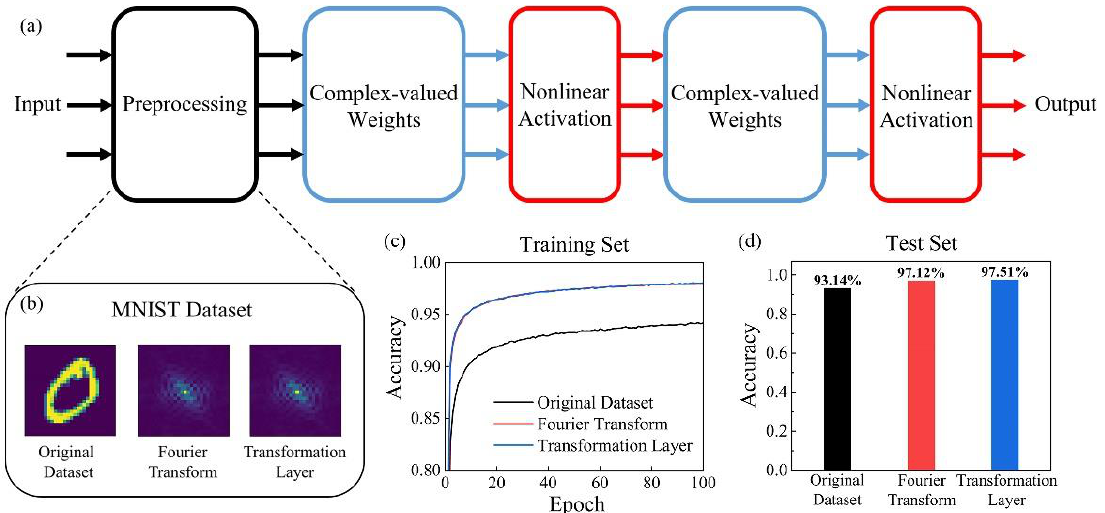
Figure 4. ( a ) A two-layer PCNN with preprocessing. ( b ) Different preprocessing of the MNIST dataset. Classification accuracies of the PCNN on the MNIST ( c ) training set and ( d ) the test set with different preprocessing, which are original dataset (black), Fourier transform (red) and the transformation layer (blue).